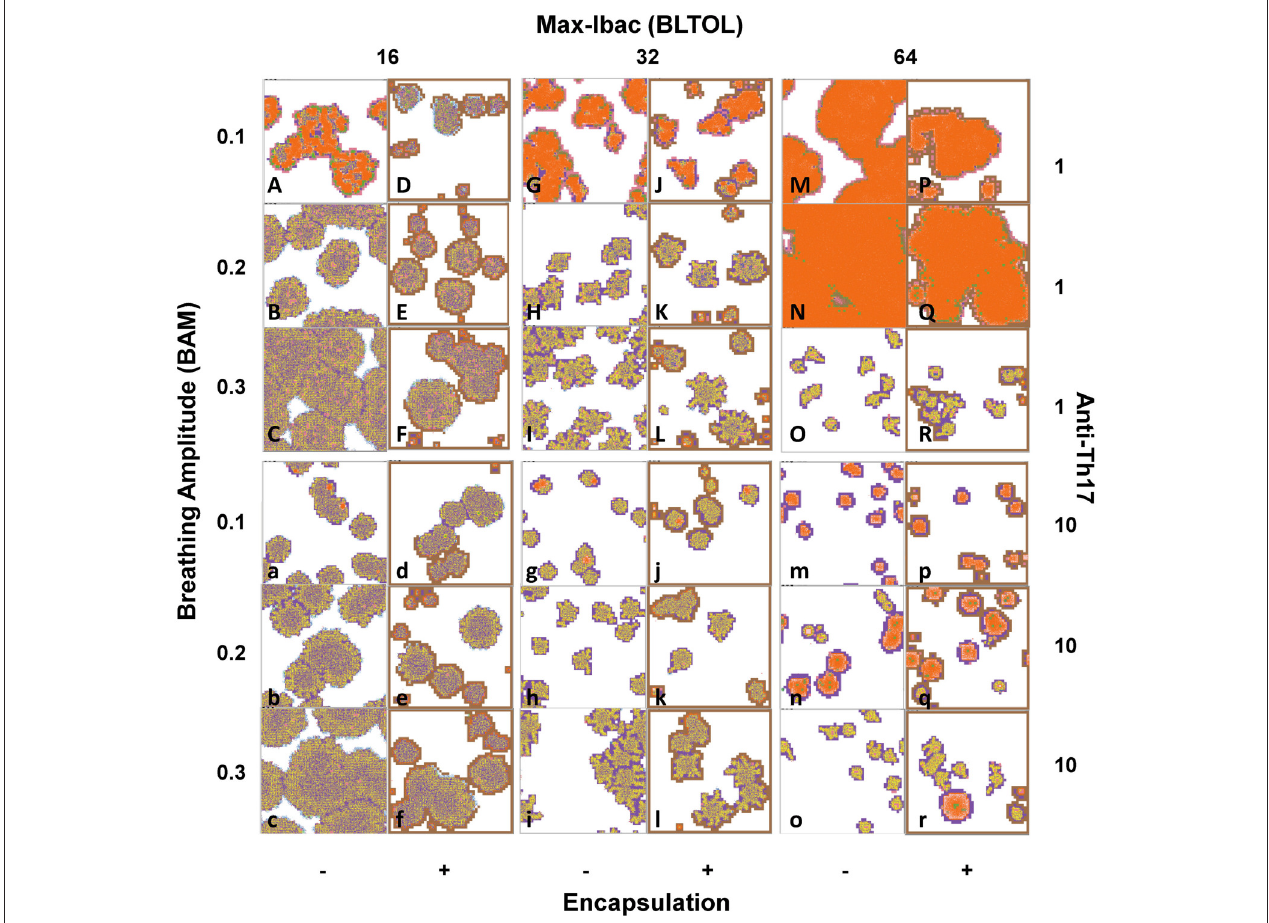
FIGURE 10 | Phenotypical characteristics of the lesions after running the program until day 46 post-challenge. Type A .- Proliferative in progression, with low quantities of Dbac and a high proportion of Kbac (pictures B, C, F, b, c and f). Type C .- Exudative, based on a large necrotic center surrounded by an active ring of alveoli filled with PMNs and the massive presence of Dbac (pictures A, G, J, M, N, P and Q). Type D .- Exudative controlled, with smaller lesions than in type C surrounded by a ring of aAMs (pictures g, j, m, p, n, q and r). Type B .- Proliferative controlled, as there is a very low quantity of Dbac and a very high proportion of Kbac (all other pictures). Colors: Alveoli: White : when a single AM is present; Black : when the AM is destroyed; Blue : when the AM is destroyed and replaced by another AM from the interstitium; Violet : when an activated AM (aAM) is present; Pink : when neutrophils occupy the alveoli; Brown : capsule. Bacilli: Blue challenge bacilli; Red : Intracellular bacilli (Ibac); Green : Extracellular (Ebac); Brown : growing Ebac; Orange : dormant (Dbac); Yellow : killed bacilli